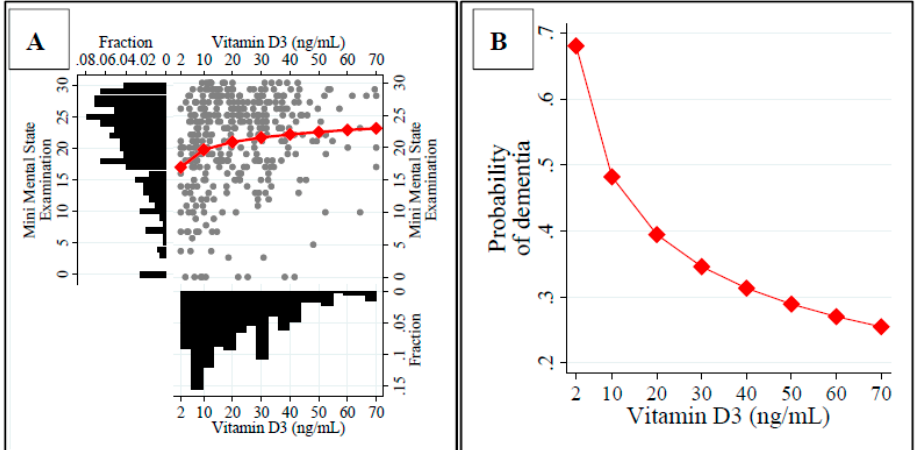
Figure 2. Relationship between the vitamin D level and the score of the Mini Mental Score Examination ( A ) or the diagnosis of dementia ( B ) in an average geriatric patient: Results of the Bayesian model averaging approach.